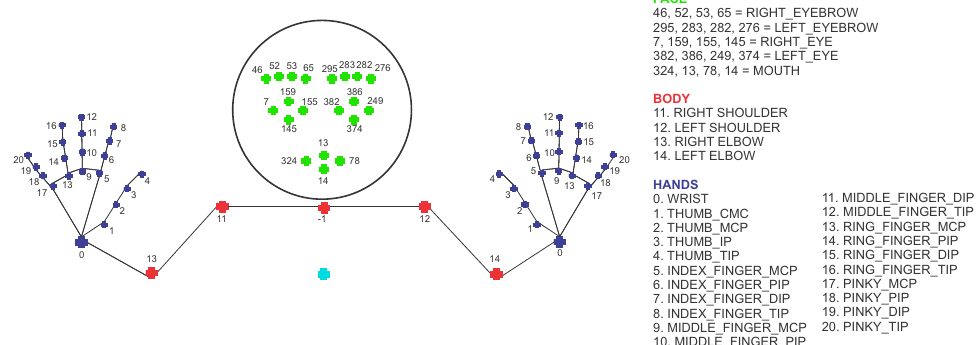
Figure 2. Face, body, and hand selected keypoints. The numbers indicate the landmark indices used in the MediaPiple